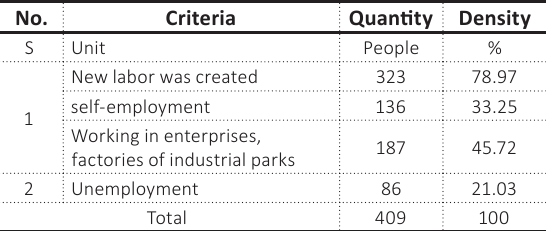
Table 2. Survey results on employment when building and developing industrial parks